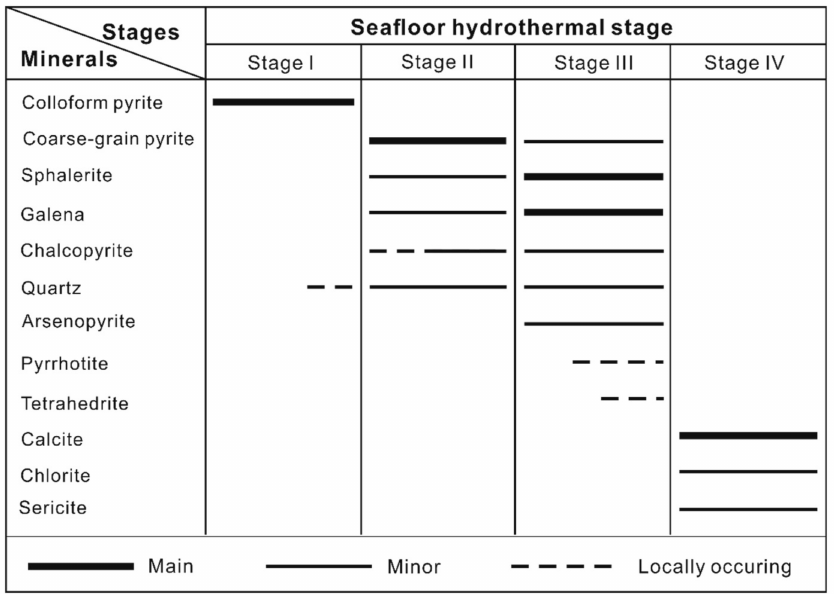
Figure 7. Mineral paragenesis in the Laochang Ag-Pb-Zn-Cu